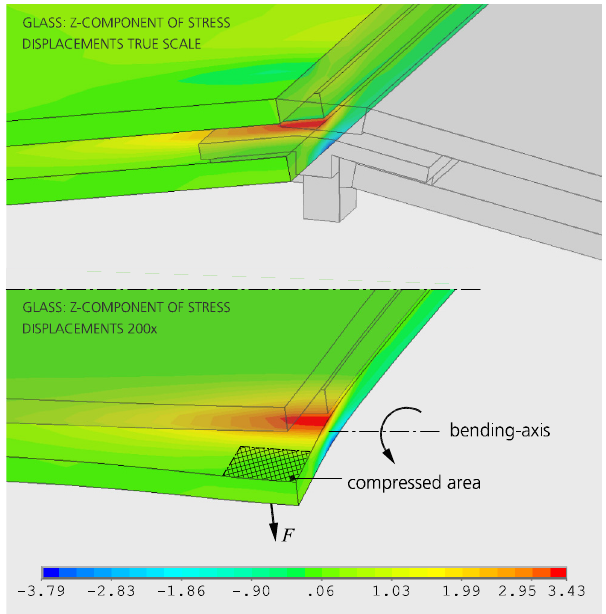
Figure 13: Stresses in the glass panes due to transversal force at the